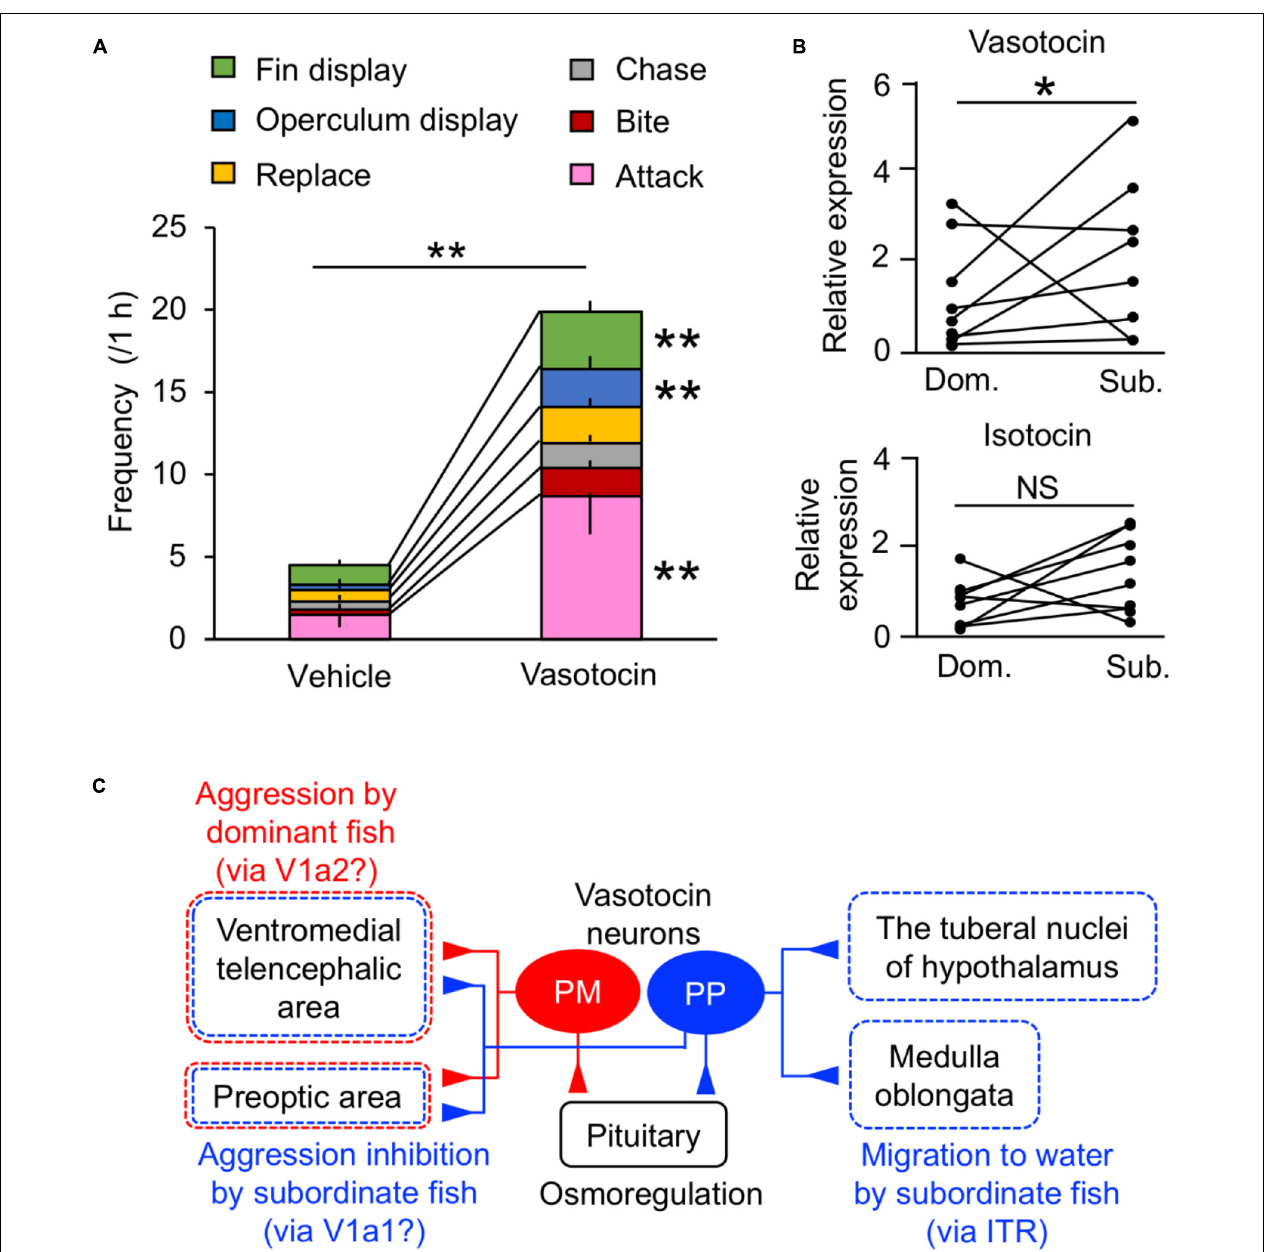
FIGURE 3 | Behavioral actions of vasotocin in mudskippers. (A) The frequency of each type of aggressive behavior after injection of vasotocin (500 pg/g-bw) or vehicle in mudskippers ( n = 6). A size-matched pair of males was used for behavioral observation in a tank with aquatic and terrestrial areas. Data are shown as the means ± SE. ∗∗ p < 0.005 with t -test. (B) The expression of vasotocin and isotocin mRNAs in dominant (Dom.) and subordinate (Sub.) mudskippers ( n = 7). Upon introduction in an experimental tank with aquatic and terrestrial areas, a pair of males can be classified as aggressive dominant or submissive subordinate based on the frequency of their aggressive behaviors, which is significantly higher in dominant male. Points of each pair are connected. ∗ p < 0.05 with Mann–Whitney U -test. NS, not significant. The original data for (A) and (B) are published in Kagawa et al. (2013). (C) A model illustrating the potential influence of vasotocin neurons on the regulation of aggressive behavior. The cell bodies of vasotocin are localized in the magnocellular (PM) and the parvocellular (PP) preoptic nucleus. Vasotocin may act via V1a-type receptors (V1a1/V1a2) in the ventromedial telencephalic area and the preoptic area to regulate general aggressive behavior. PM cells and V1a2 may mediate aggression by dominant males, while PP cells and V1a1 may mediate submissive behaviors by subordinate males. Since stimulation of migration to water by both vasotocin and isotocin is inhibited by the blocker of isotocin receptor (ITR), brain regions where both vasotocin and isotocin fibers are localized, such as the tuberal nuclei of the hypothalamus and the medulla oblongata, may regulate the amphibious behavior via ITR. The main receptors for specific behaviors are given in parentheses. Broken lines show possible brain regions involved in each behavior.